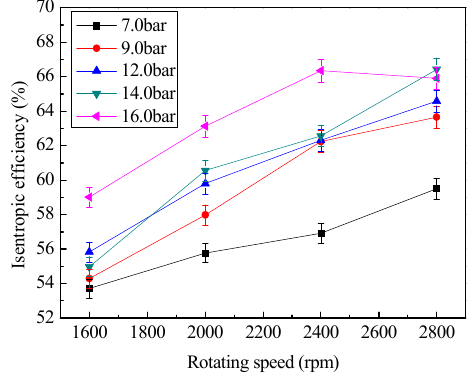
Figure 8. Isentropic efficiency versus rotating speed.